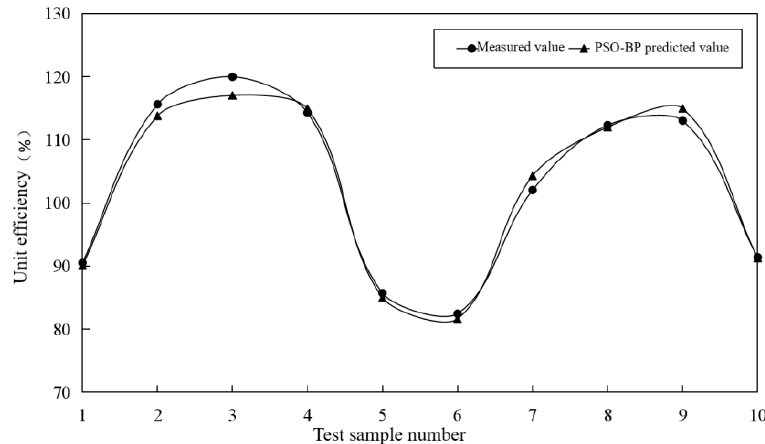
Figure 11. The predicted value of PSO-BP ANN on the unit efficiency.